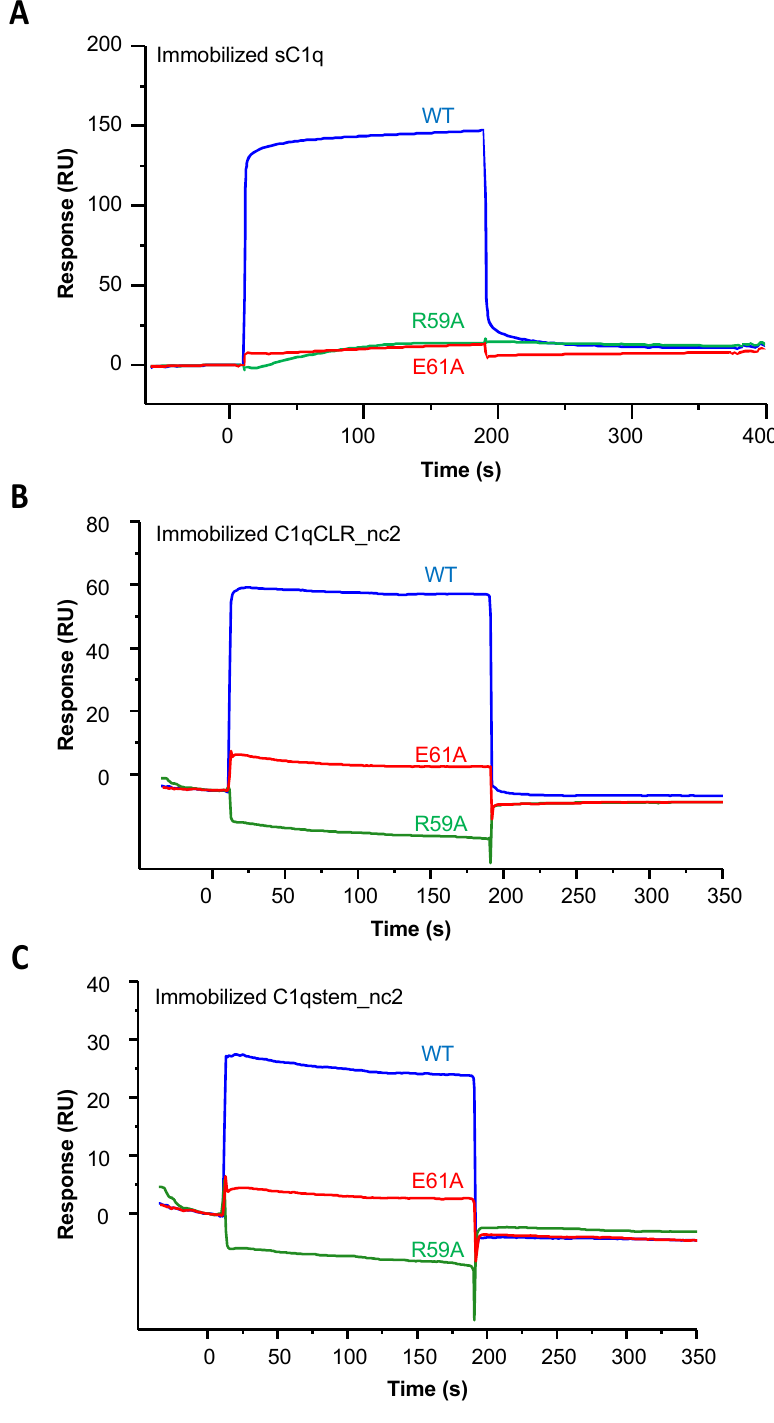
Figure 6. LAIR-1 R59A and E61A mutations abrogate the interaction with C1q and its variants. LAIR-1 WT (blue curves), R59A (green curves) and E61A (red curves) were injected at a concentration of 10 µM over immobilized sC1q ( A ), C1qCLR_nc2 ( B ) and C1qstem_nc2 ( C ).